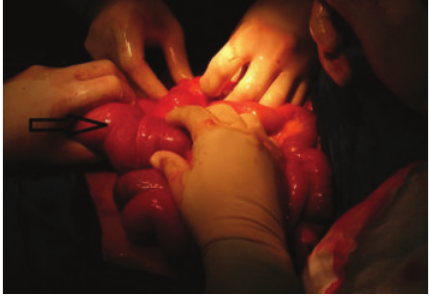
Figure 2: Attempt at reduction of the intussusception in the retrograde direction marked by the black arrow.